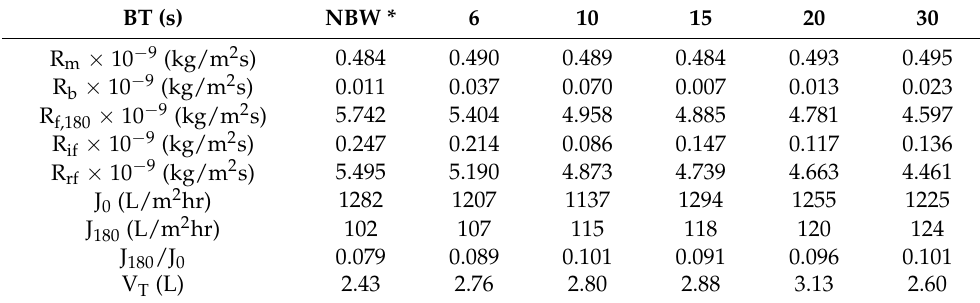
Table 2. Influence of water backwashing time on filtration factors in the combined process of tubular alumina MF (NCMT-7231) membrane and PP beads with periodic water backwashing. BT (s) NBW * 6 10 15 20 30 R m × 10 − 9 (kg/m 2 s)